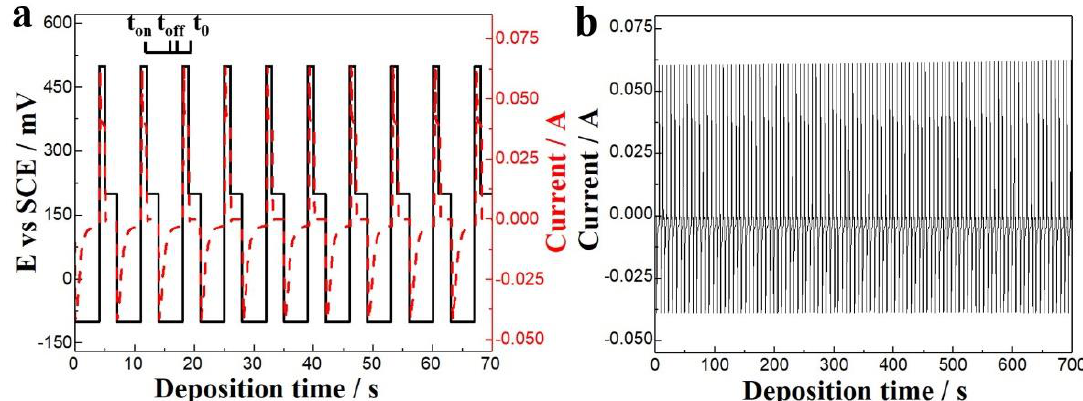
Figure 11. ( a ) The pulsed voltage and current vs. time during deposition. ( b ) The current vs. time for 100 cycles in the middle of the deposition.